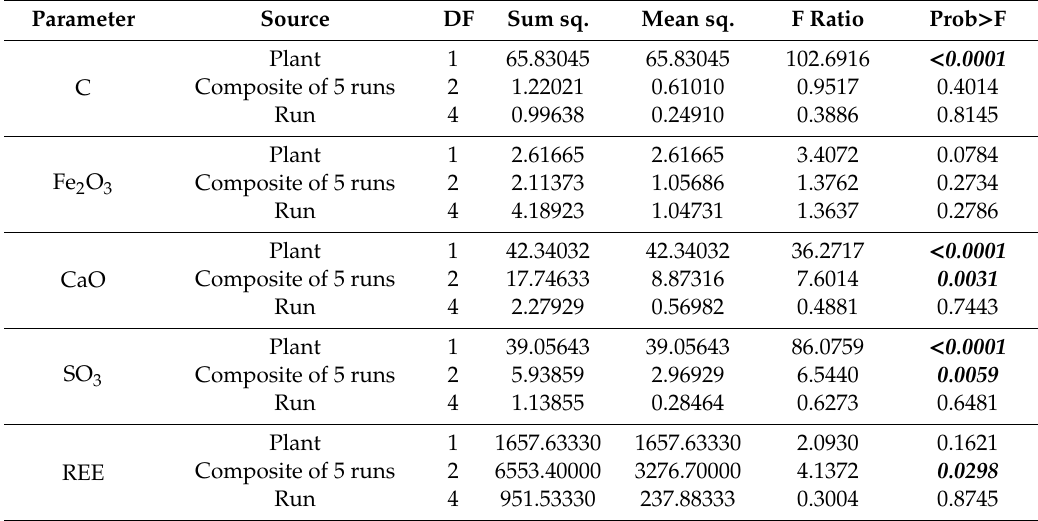
Table 4. Analysis of variance results (sq.—squares;